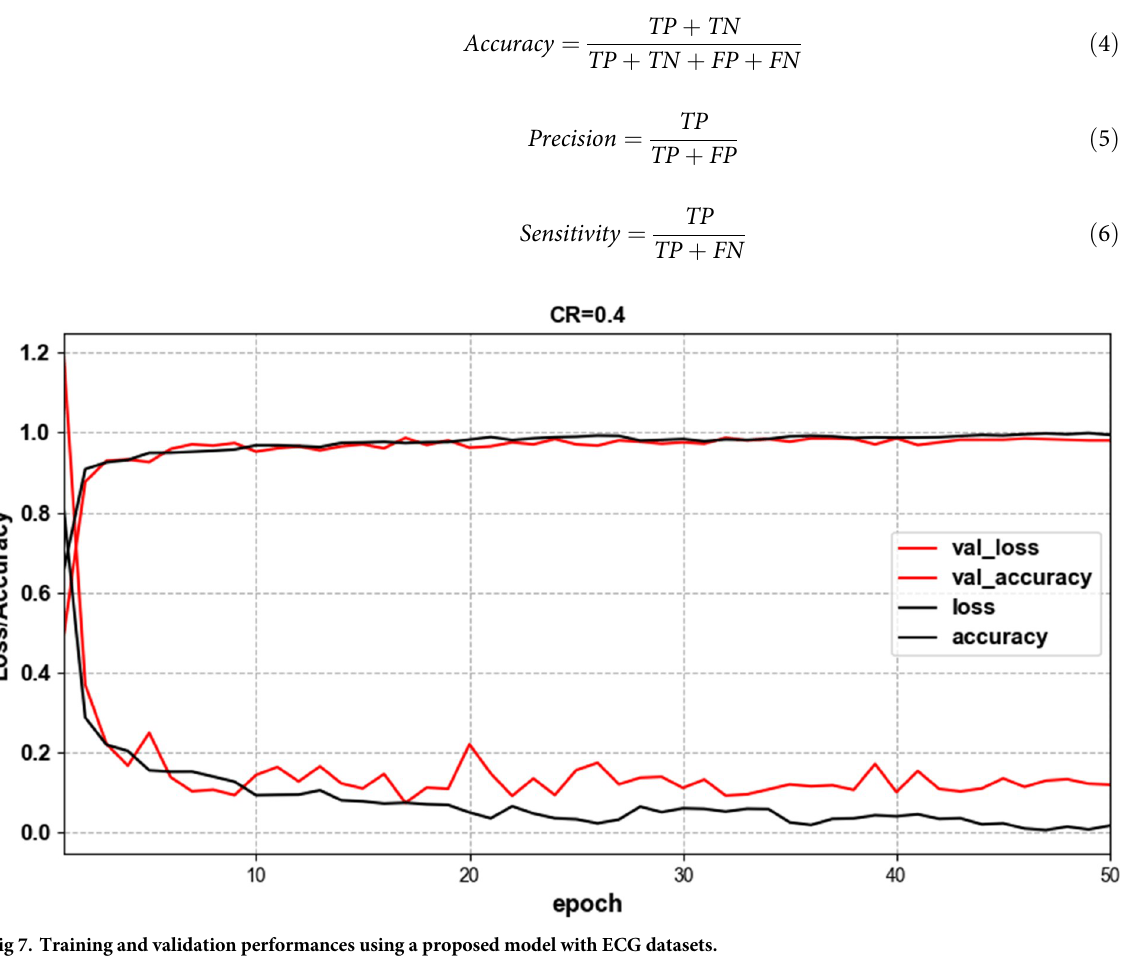
PLOS ONE | https://doi.org/10.1371/journal.pone.0284008 April 4,